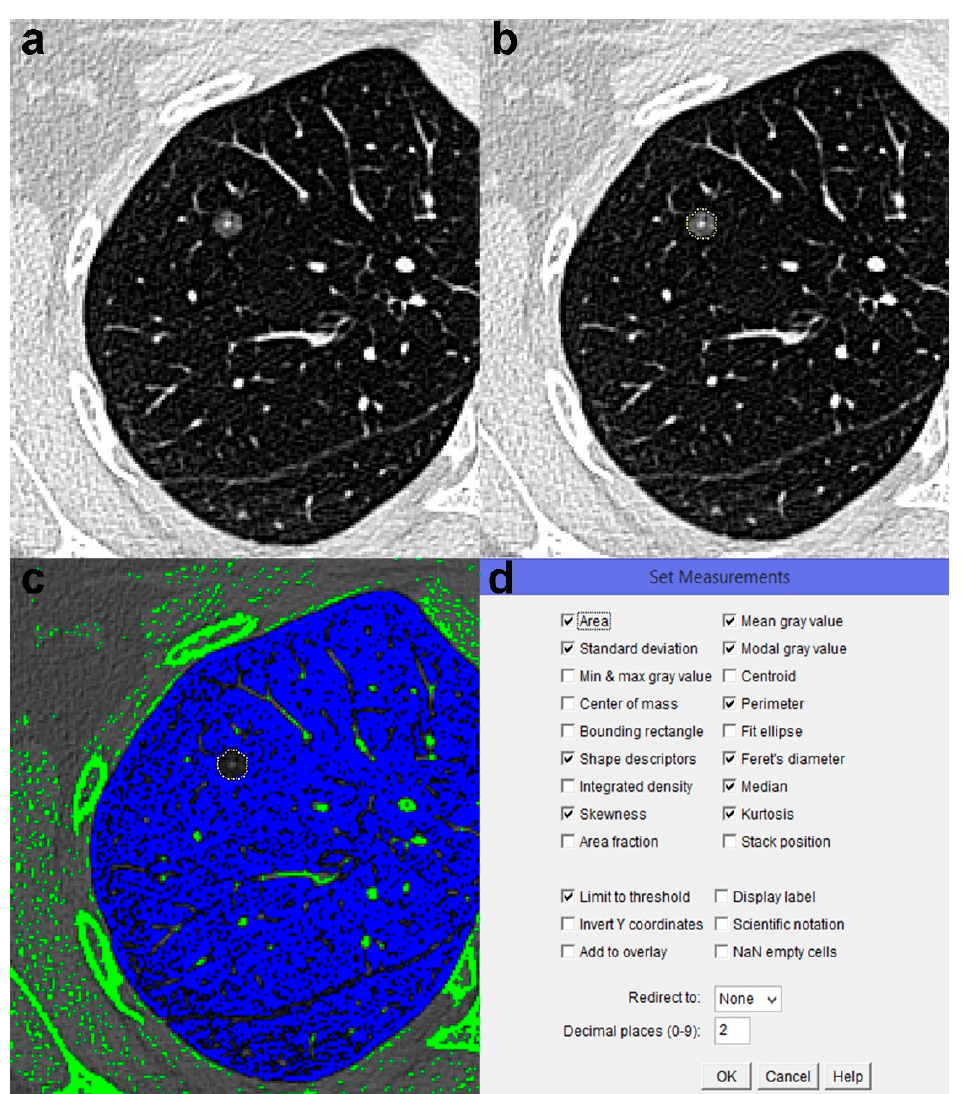
Figure 1. Example of segmentation process and computerized analysis performed using ImageJ software in a part-solid nodule (PSN). Step 1: importing the computed tomography (CT) images in DICOM format to ImageJ software ( a ). Step 2: drawing a polygonal region of interest (ROI) that outlined the nodule contours on the largest cross-sectional area of the lesion ( b ). Step 3: checking and manually correcting any segmentation error. Step 4: clicking “Image” on the ImageJ toolbar and selecting “Adjust → Threshold”. Step 5: choosing a suitable CT attenuation value to excluded pixels with air attenuation around and within the PSNs (CT attenuation value, − 800 HU) ( c ). Step 6: clicking “Analyze” on the toolbar, selecting “Set Measurement” and checking the quantitative features of interest ( d ). Step 7: clicking “Analyze” again and then clicking “Measure”, to automatically calculate the selected quantitative features.